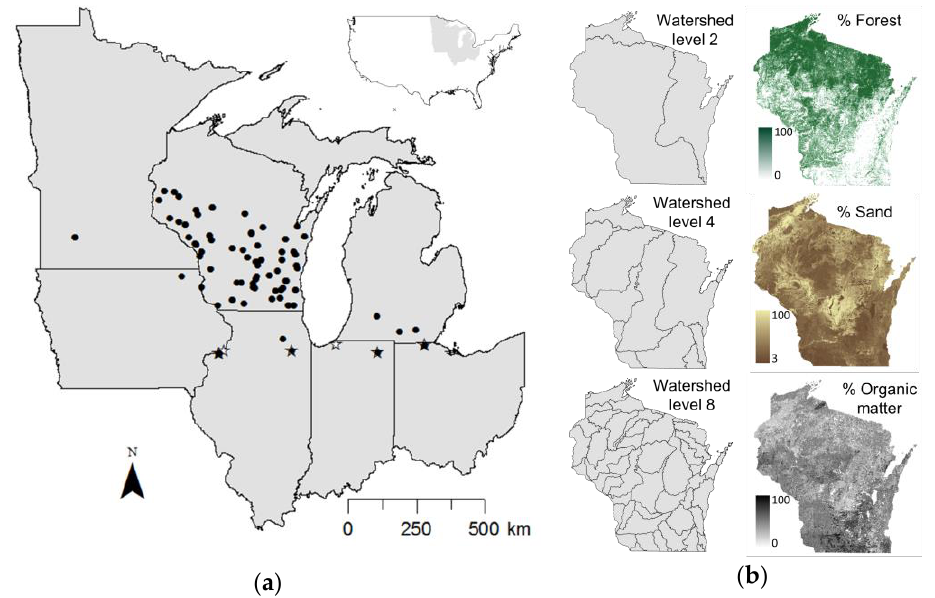
Figure 1. ( a ) Locations of Rhamnus cathartica leaf samples collected between May–June of 2015 (black circles; n = 90 sites) and known Aphis glycines overwintering sites (stars). Filled stars represent overwintering sites where buckthorn and aphid samples were obtained in 2015. ( b ) Environmental variables (% forest cover, % sand in surface soils, % organic matter in surface soils, watershed levels [corresponding to HUC2, HUC4, and HUC8]) used to detect associations with R. cathartica 𝛿 13 C and 𝛿 15 N among Wisconsin sites.